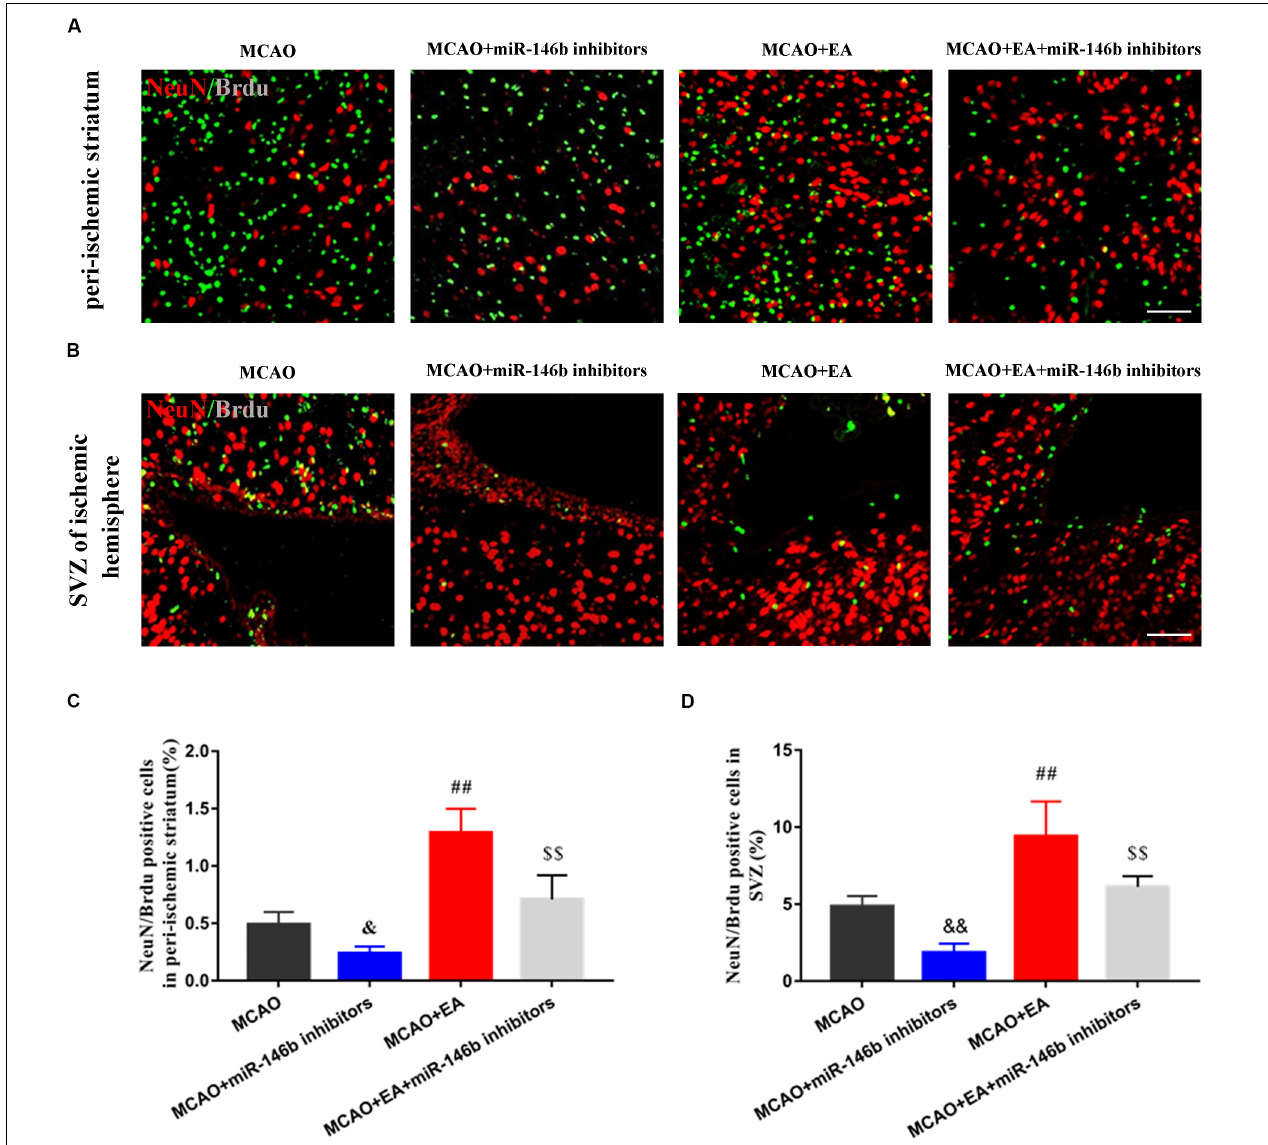
FIGURE 2 | Electro-acupuncture promotes the differentiation of endogenous neural stem cells into neurons in peri-ischemic striatum and SVZ of ischemic hemisphere. (A) Immunofluorescence and co-localization of NeuN with BrdU in peri-ischemic striatum (B) . Immunofluorescence and co-localization of NeuN with BrdU in the subventricular zone (SVZ) of ischemic hemisphere. (C,D) The positive cells of co-localization of NeuN/Brdu in peri-ischemic striatum and SVZ of ischemic hemisphere, respectively ( n = 4). Data represent means ± SD of the results of representative experiment. & P < 0.05 and && P < 0.01, MCAO vs. MCAO+miR-146b inhibitors; ## P < 0.01, MCAO vs. MCAO+EA; $$ P < 0.05, MCAO+miR-146b inhibitors vs. MCAO+EA+miR-146b